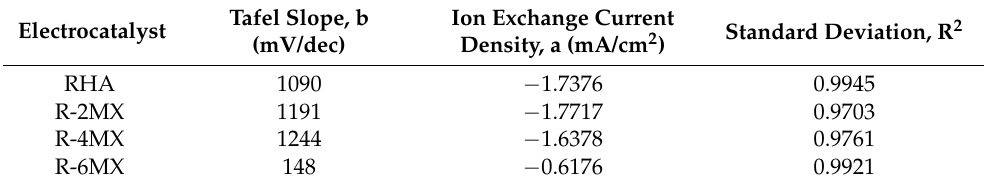
Table 1. Tafel slope analysis of different weight percentages of RHA and MXene electrocatalysts. Tafel Slope, b Ion Exchange Current Electrocatalyst (mV/dec)